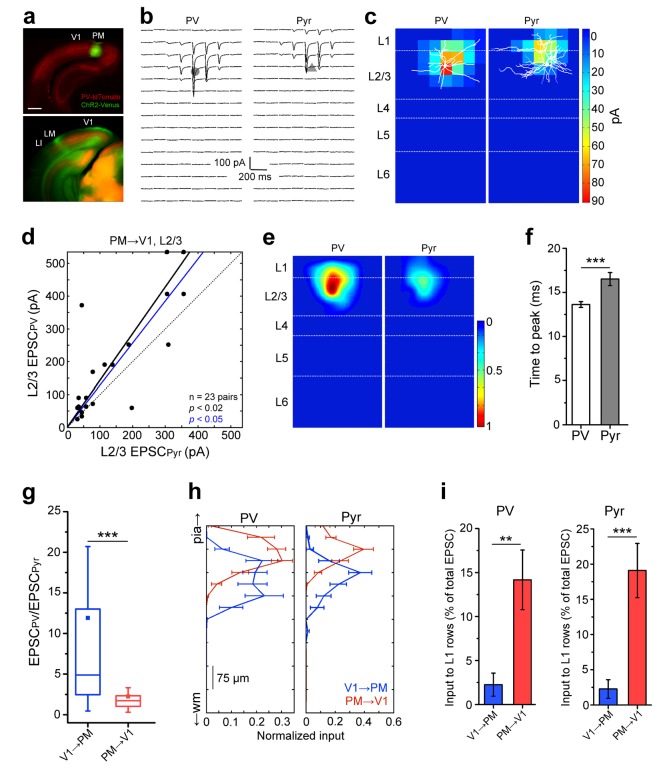
Lower I/E balance in PM→V1 pathway.(a) Coronal slices showing AAV2/1.CAG.ChR2-Venus (green) injection in PM (top) and axonal labelling in target areas (bottom) of a PV-tdT (red) mouse. Scale bar, 1 mm. (b) EPSCssCRACM in a pair of neighboring PV (left) and Pyr cells (right) in V1. (c) Heat map of the currents in 4b superimposed with biocytin-filled neurons (white). Note significant input into L1 of both cell types. (d) PV cells, on average, exhibit larger EPSCssCRACM than neighboring Pyr cells in the PM→V1 pathway (p<0.02, Wilcoxon signed-rank test). Solid black line: mean slope of data points; blue line: mean slope after normalization to cell conductance. (e) Normalized, mean heat map of all L2/3 pairs in the FBPM→V1 pathway. (f) EPSCs are faster in L2/3 PV than in neighboring Pyr cells upon stimulation of FBPM→V1 axon terminals (*p<0.001, paired t-test). (g) The interareal excitation of PV cells, normalized to that of neighboring Pyr cells, is on average larger in the FFV1→PM than in the FBPM→V1 pathway (***p<0.001, Mann-Whitney U-test). (h) Total currents in each row of the 8 × 16 grid for FFV1→PM and FBPM→V1 pathways plotted against relative position of each of the 16 rows. EPSCs normalized to total EPSC in each cell-type. pia, pia mater; wm, white matter. (i) Interareal input to L1 is stronger in the FBPM→V1 than in the FFV1→PM pathway in both cell types (**p<0.01, ***p<0.001, Mann-Whitney U-test). L1 input was calculated as the mean of the total input to each row of the 8 × 16 grid that resided in L1, presented as the percentage of the total input to the neuron.